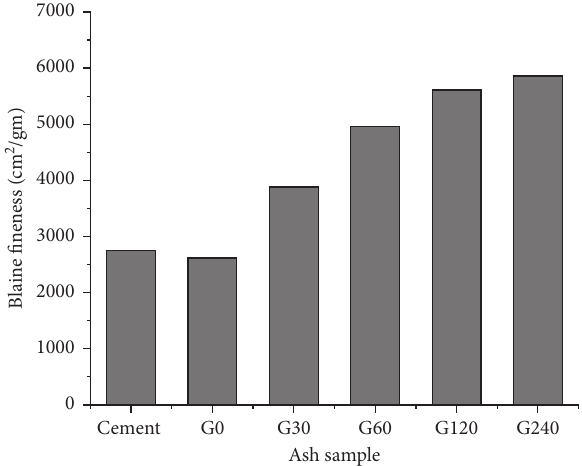
Figure 14: Specific surface areas at different grinding times.